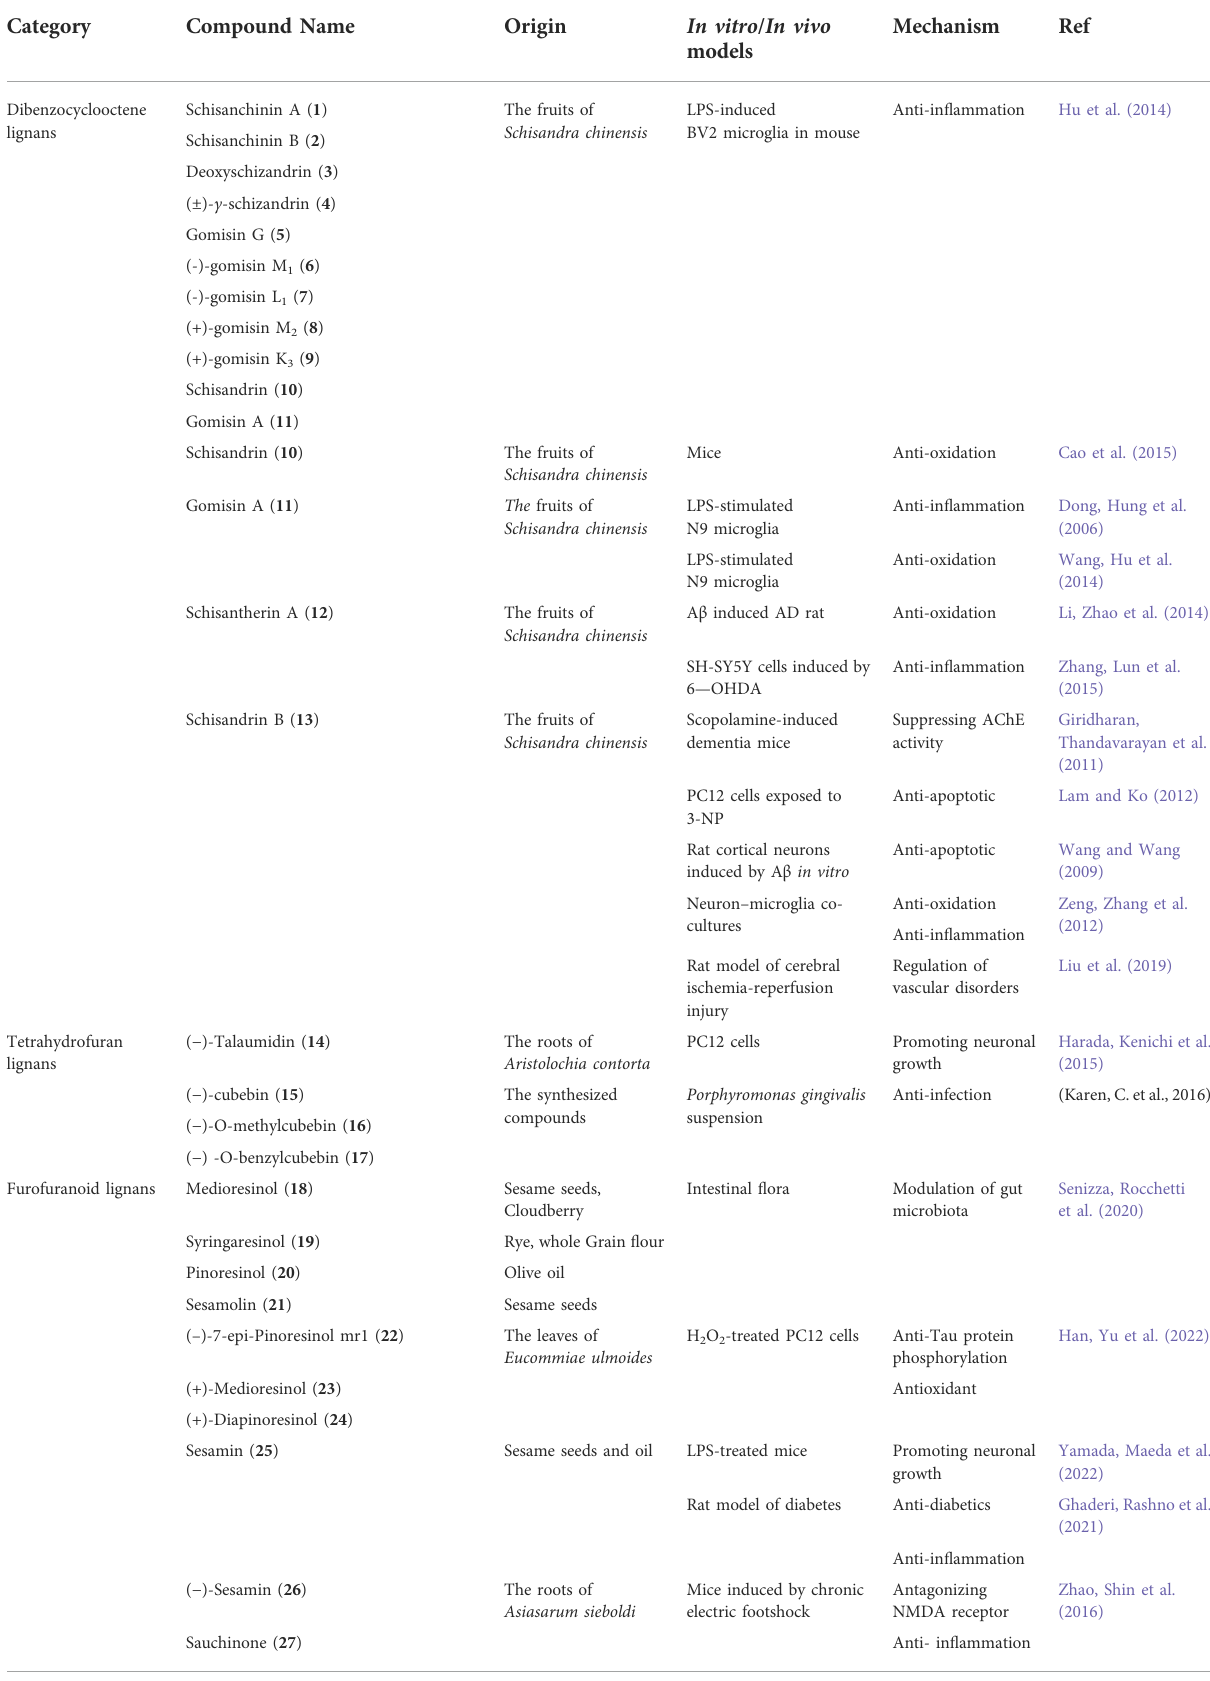
TABLE 1 The action mechanisms of major